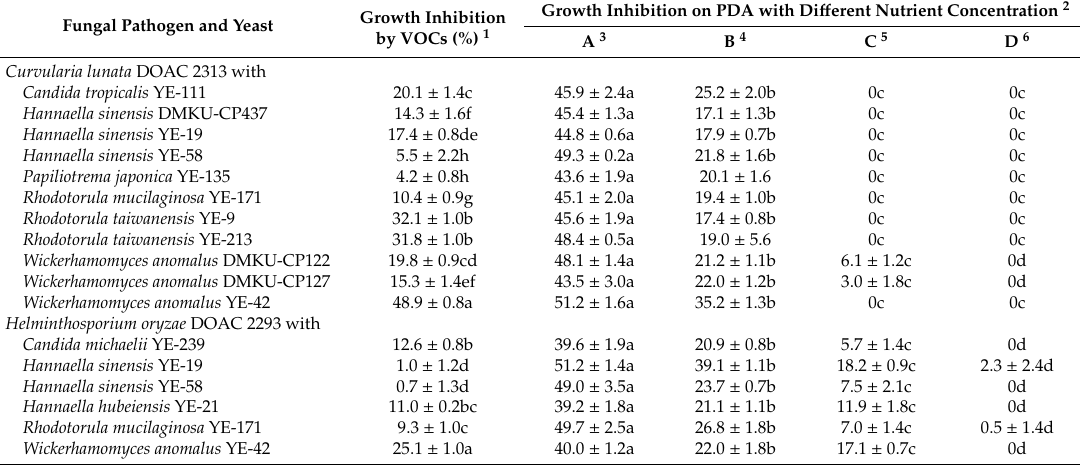
Table 1. Growth inhibition of Curvularia lunata DOAC 2313 and Helminthosporium oryzae DOAC 2293 by antifungal volatile organic compounds (VOCs) produced by antagonistic yeasts, on PDA containing di ff erent nutrient concentrations.